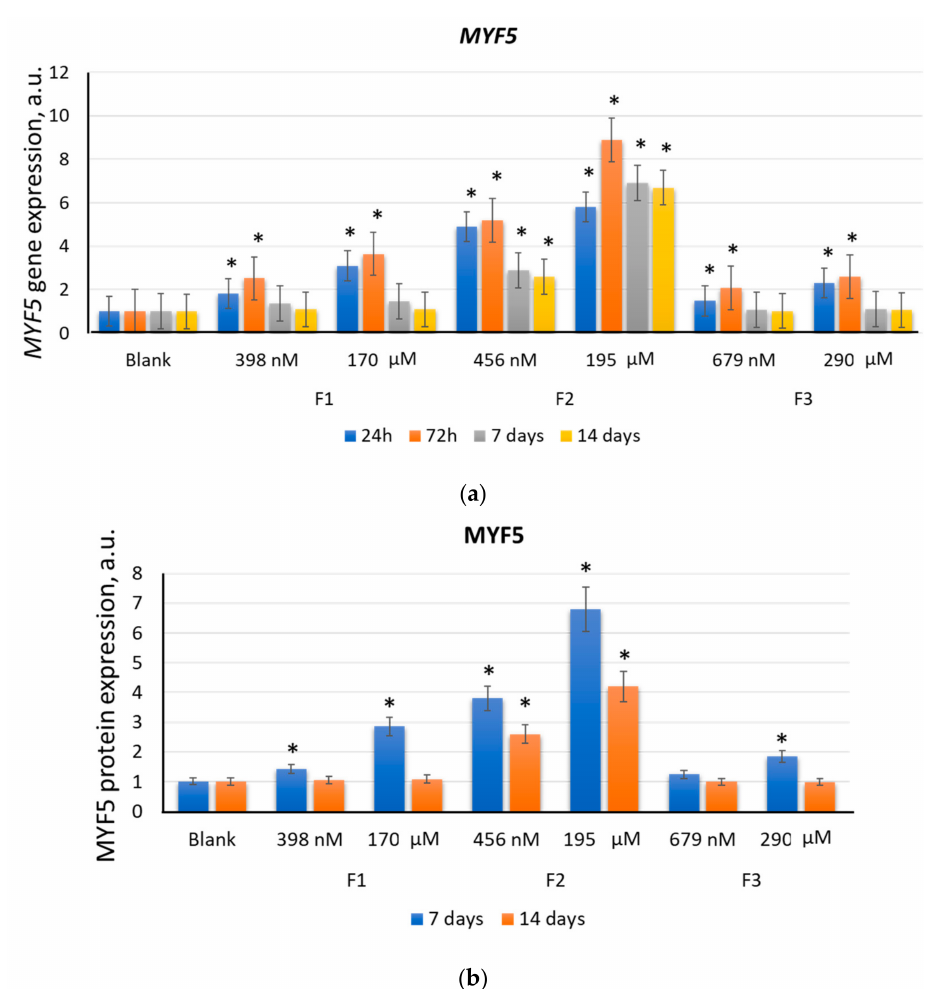
Figure 4. The effect of F1, F2, and F3 on the MYF5 gene expression ( a ) and MYF5 protein expression ( b ); the concentrations and exposition times are shown in the figure. The gene RNA amount was the mean value for three experiments related to the blank; the TBP gene was used as an internal reference gene; (*) denotes significant differences compared to blank cells, p < 0.005, in a Mann–Whitney test. In blank experiments, cells were incubated without the